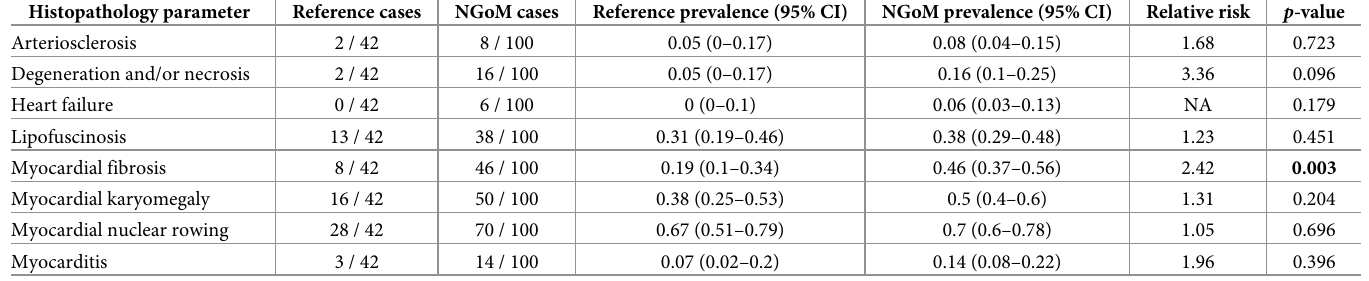
Table 4. Prevalence of heart lesions identified histopathologically in dolphins stranding in the NGoM from 2010-February 2019 compared to the lesion prevalence in reference dolphins.